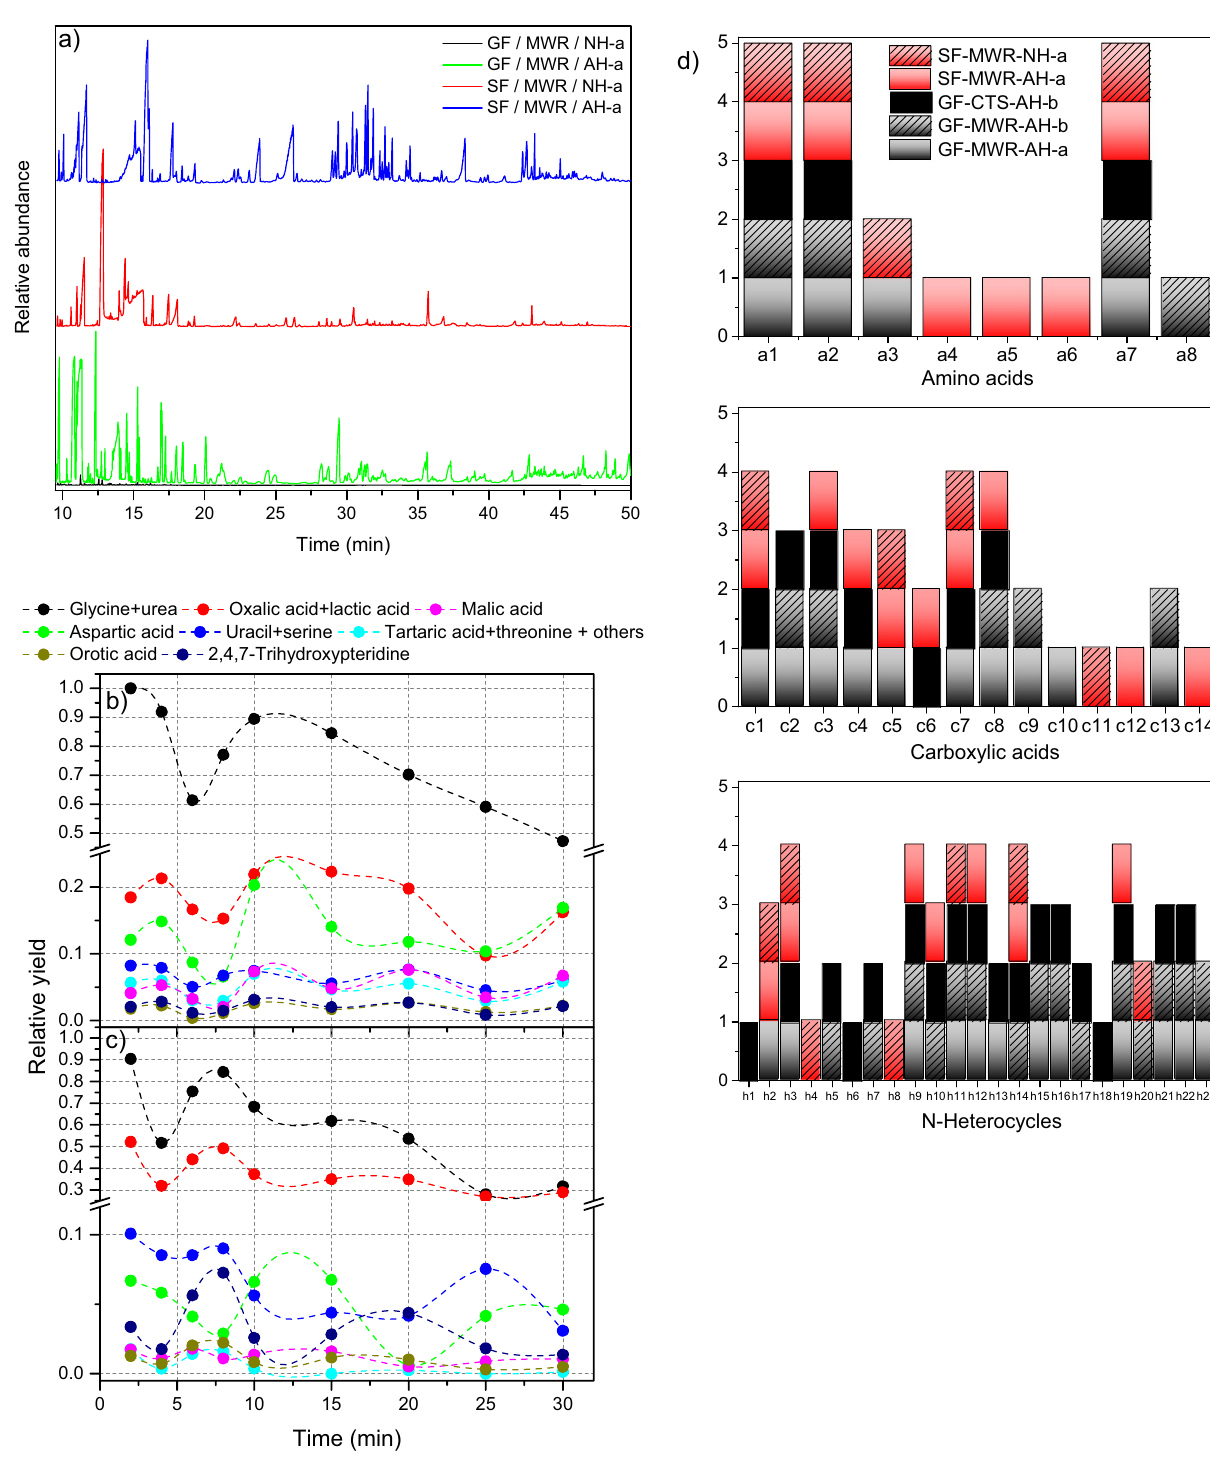
Figure 5. SF = sol fraction; GF = gel fraction; MWR = microwave radiation; CTS = conventional thermal system; AH = acid hydrolysed sample; NH = unhydrolysed samples; a and b = GC–MS methods (please see experimental section). ( a ) GC–MS profiles of unhydrolysed and acid hydrolysed samples from the NH 4 CN polymerization under anoxic conditions and microwave radiation using a reaction time of 30 min. Note that in the GC–MS profile of an unhydrolysed gel fraction sample, no well-defined polar organic compounds were identified and the relative intensity of the chromatogram signal is very low; ( b ) Semiquantitative analyses of the acid hydrolysed sol fractions. A value 1 is taken for the area of the urea peak plus the area of the glycine peak (3TMS) (please see the peak assignments in Figs. S5 and S6) in the sol fractions from the polymerization conducted at 2 min (Fig. S6). The other relative area values refer to that. Note that there are several saturated and coelution peaks. The assignment of the analytes was made using the retention time values and the profile of the mass spectra of the authentic standards. ( c ) Semiquantitative analyses of the acid hydrolysed gel fractions were performed in the same way as for the acid hydrolysed sol fractions. ( d ) Qualitative comparative analyses of the gel and sol fractions. The letter and number shown in the axis correspond to the analyte numeration indicated in Fig.